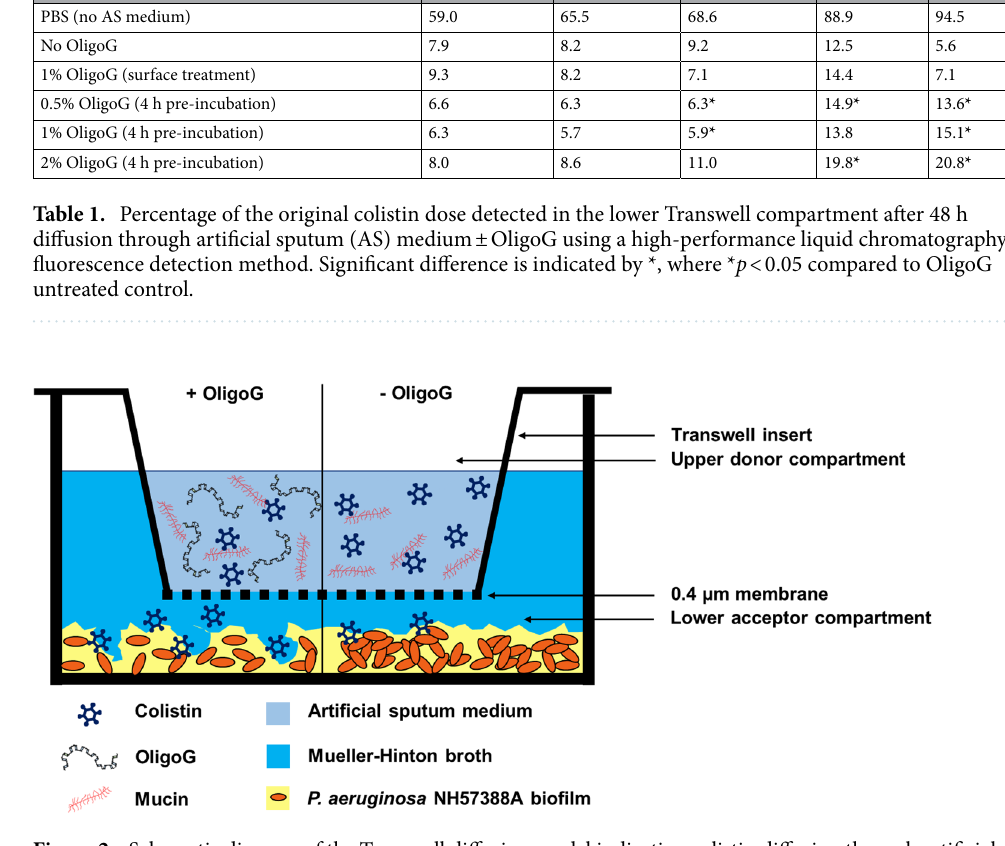
Figure 2. Schematic diagram of the Transwell diffusion model indicating colistin diffusion through artificial sputum medium ± OligoG and antimicrobial activity against cystic fibrosis clinical isolate P. aeruginosa